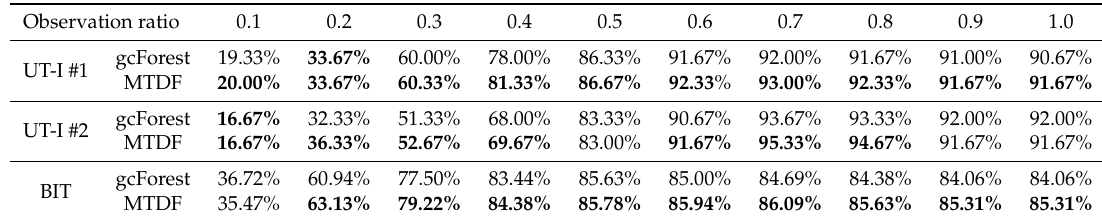
Table 1. Prediction results on UT-I #1, UT-I #2, and BIT dataset, using gcForest [8] and our multi-task deep